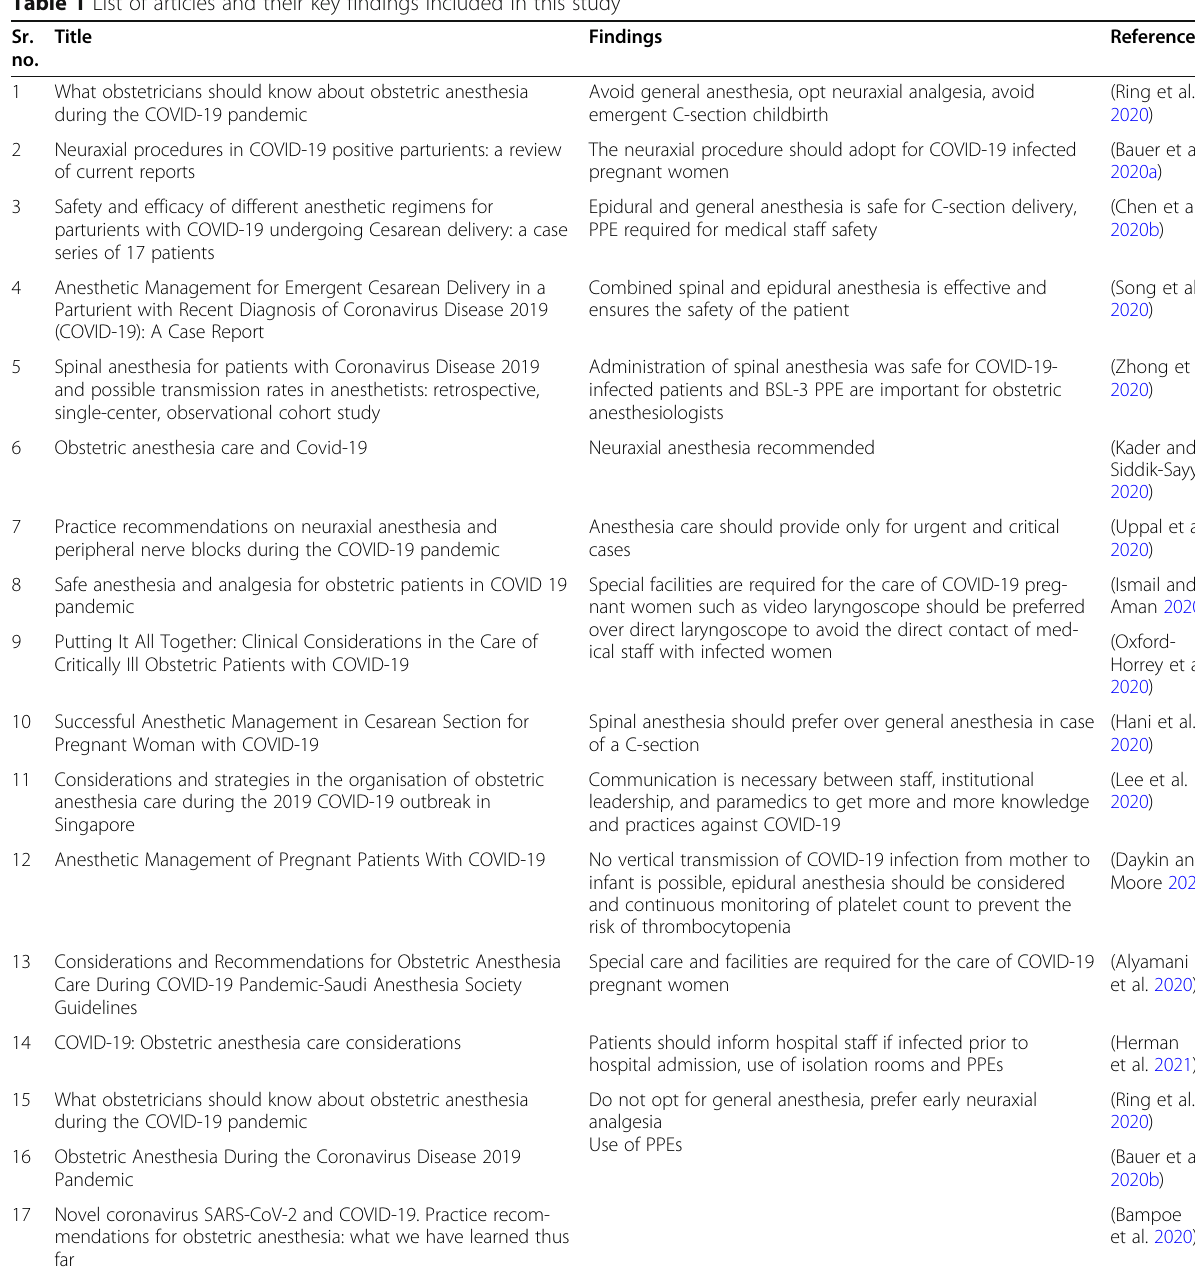
Table 1 List of articles and their key findings included in this study Sr. no.